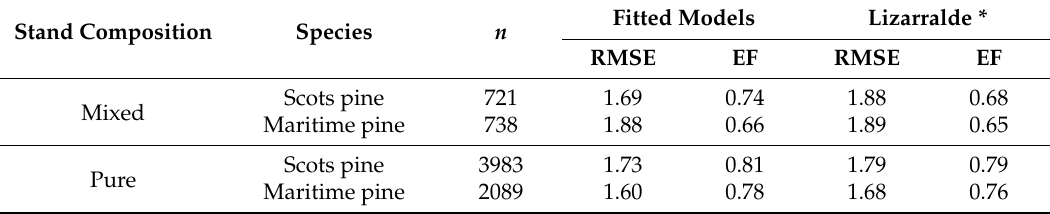
Table 3. Evaluation statistics, based on data from National Forest Inventory (NFI) plots in the North Iberian Range, comparing the best generalized h-d models fitted to the triplet data and the equations proposed by Lizarralde et al. [25,26].